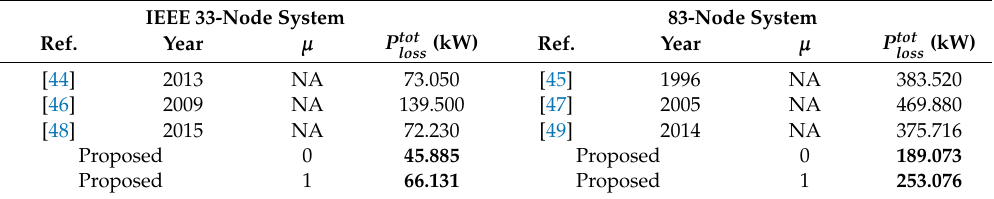
Table 10. Comparison of Previous Works with The Proposed Scenario 9. IEEE 33-Node System